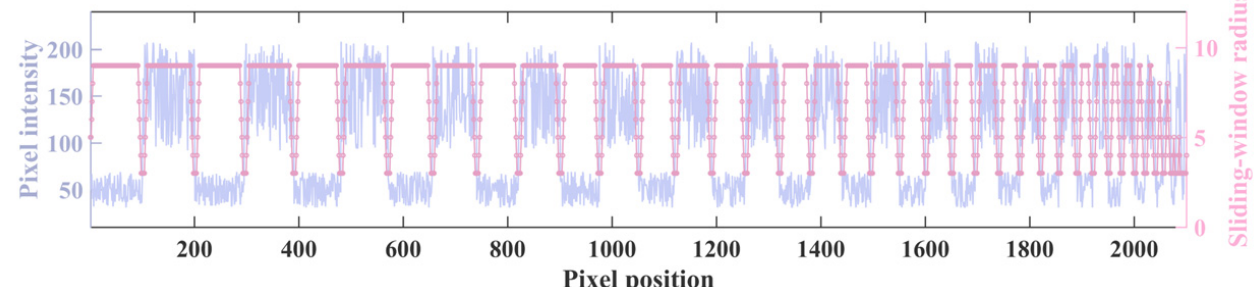
Figure 8. The experimental result for edge positioning accuracy.